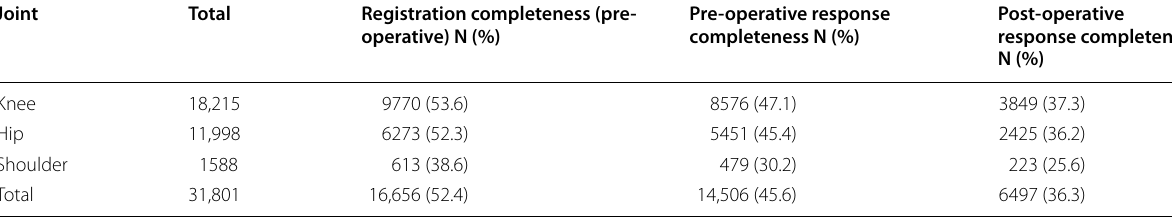
Table 1 Joint distribution by pre-operative registration and response completeness